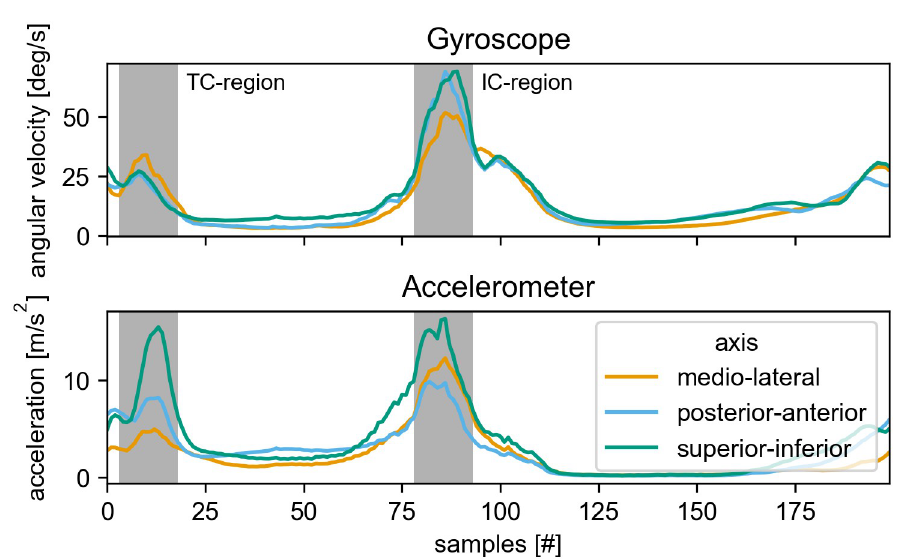
Fig 8. The STD over the different sensors per sample of a stride. The curves are the averages over all strides from the 2 × 20m walk test at normal speed. The STD of each stride was interpolated to 200 samples before averaging. The individual signals are rotated to match the primary anatomical axis during mid-stance. The approximate regions around the IC and TC are marked in gray.